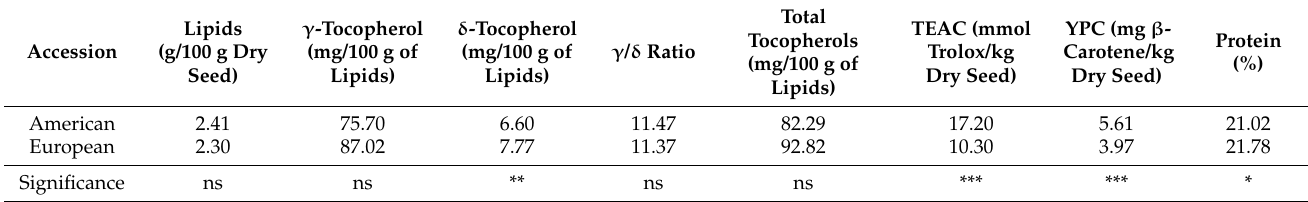
Table 4. Analysis of covariance for the mean nutritional quality traits for the American and European accessions.